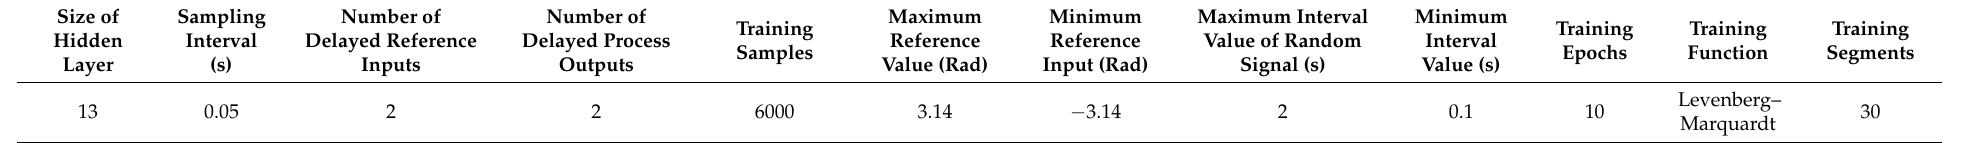
Table 9. The parameters of neural controller